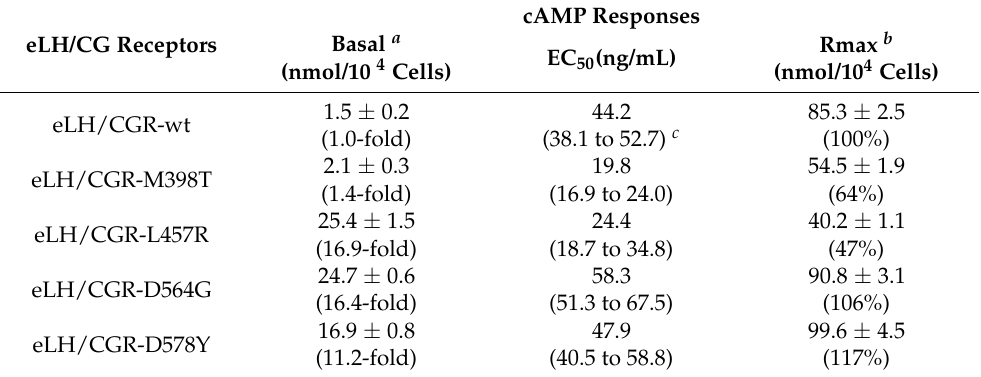
Table 1. Bioactivity of eLH/CG receptors in cells expressing activating receptor